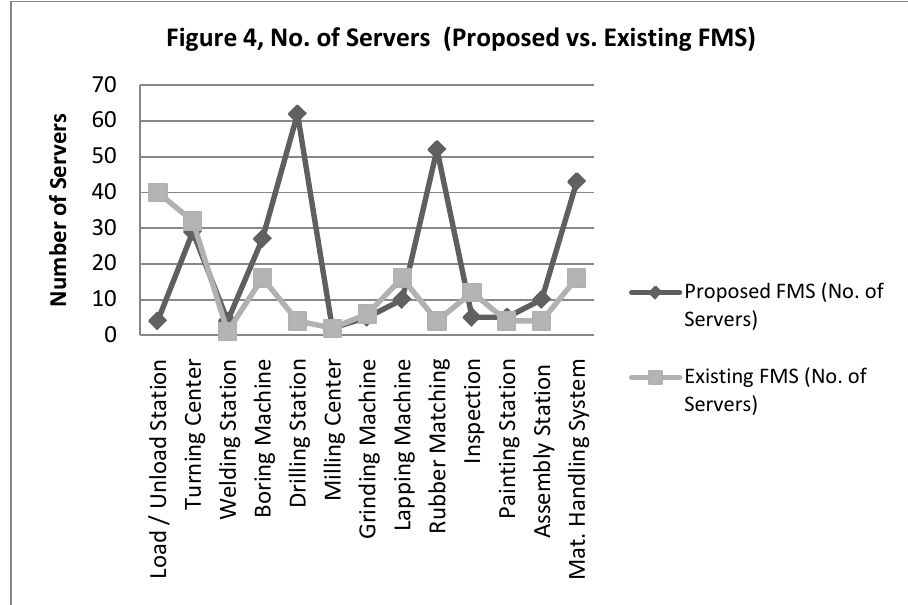
Figure 4, No. of Servers (Proposed vs. Existing FMS)